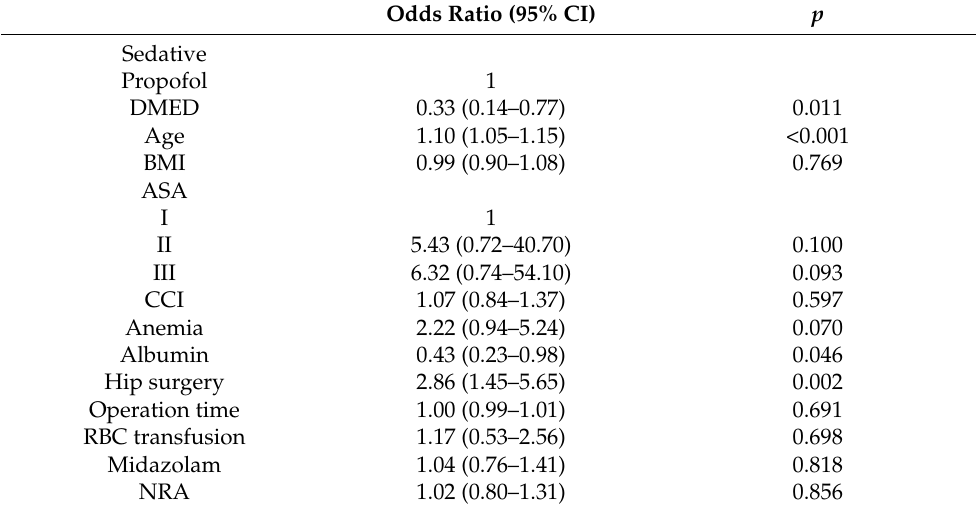
Table 4. Results of the multivariate analysis of variables associated with